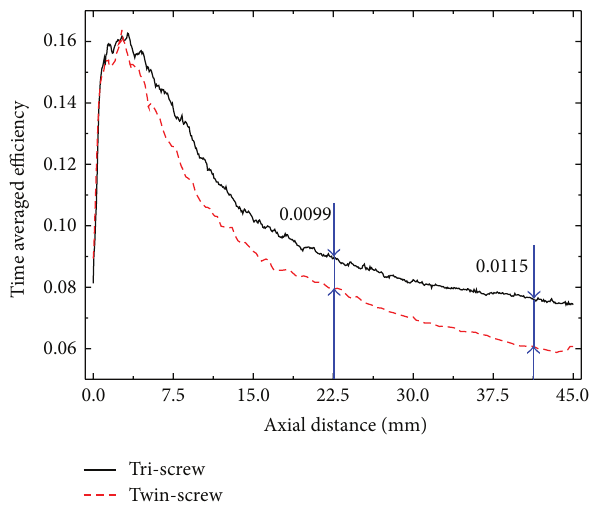
Figure 12: Time-averaged efficiency distributions of the two types of